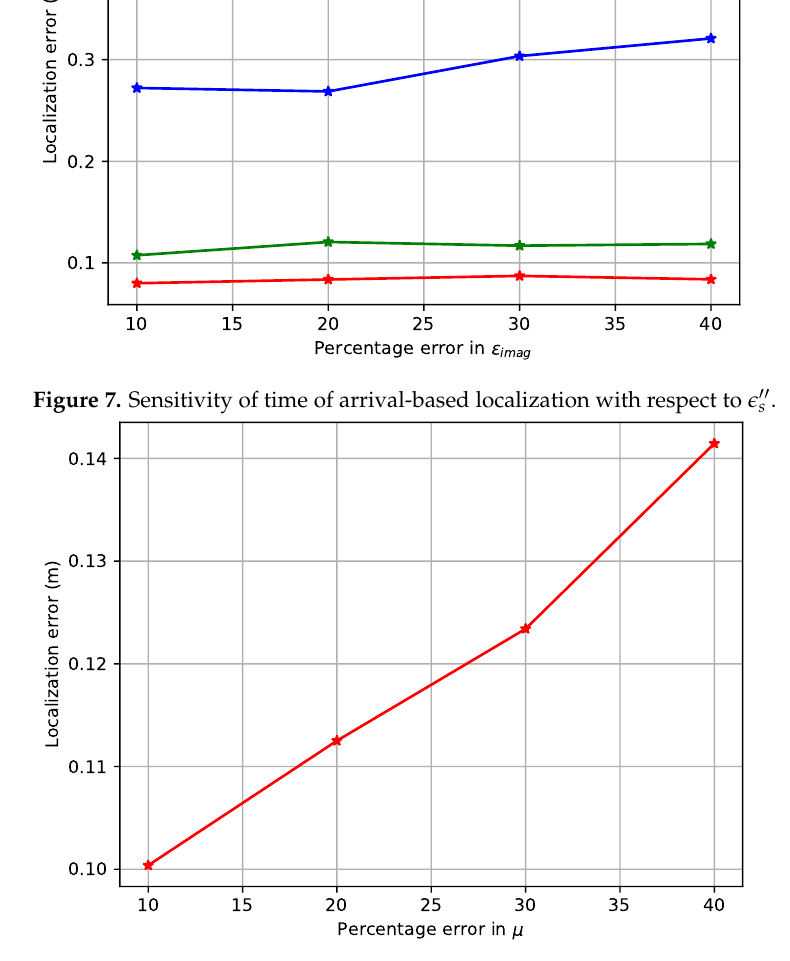
Figure 8. Sensitivity of time of arrival-based localization with respect to µ s